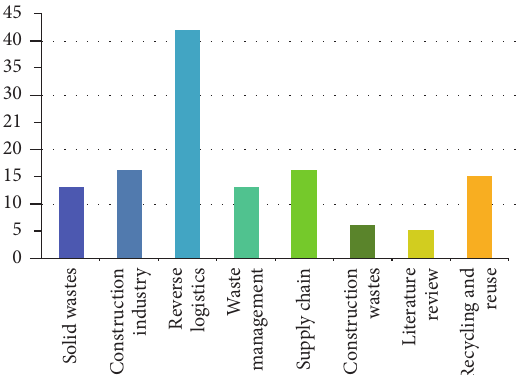
Figure 2: Number of articles that cover certain impact categories and keywords for the bibliographic